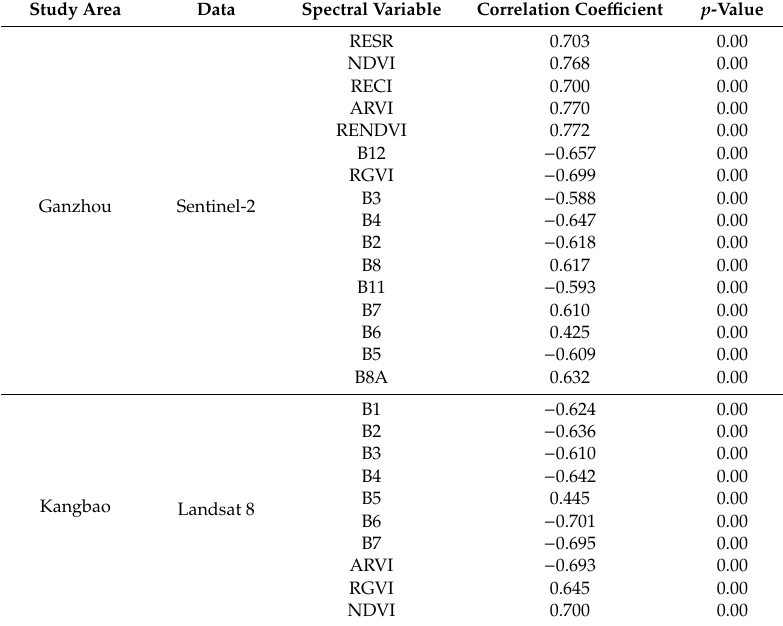
Table A2. The Pearson correlation coe ffi cients between spectral variables and LAI in Ganzhou and Kangbao.